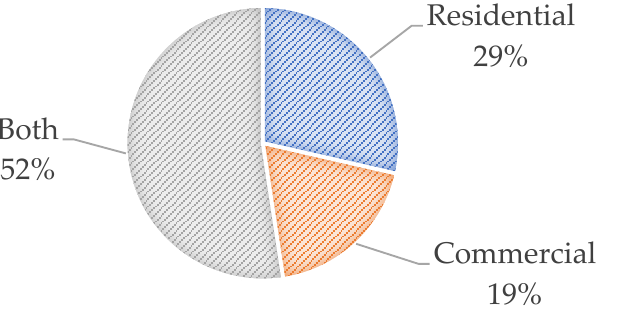
Figure 17. The frequency of building types in physics-based urban building energy modeling case studies.